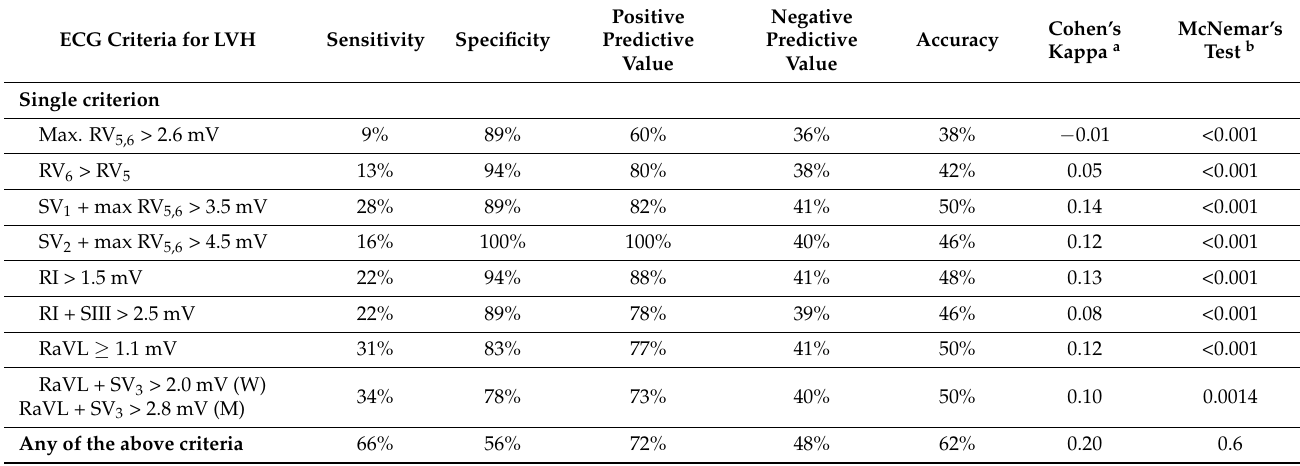
Table 2. Association of ECG criteria for LVH with echocardiographic LVH.